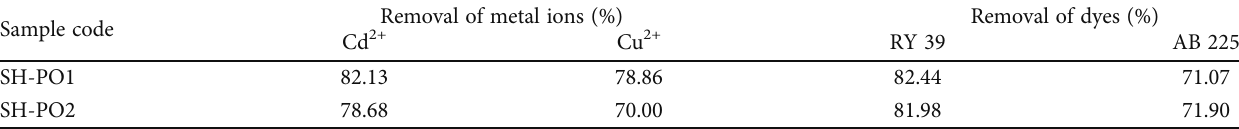
Table 2: The in fl uence of soybean hulls ’ particle sizes on the removal of pollutants. Sample